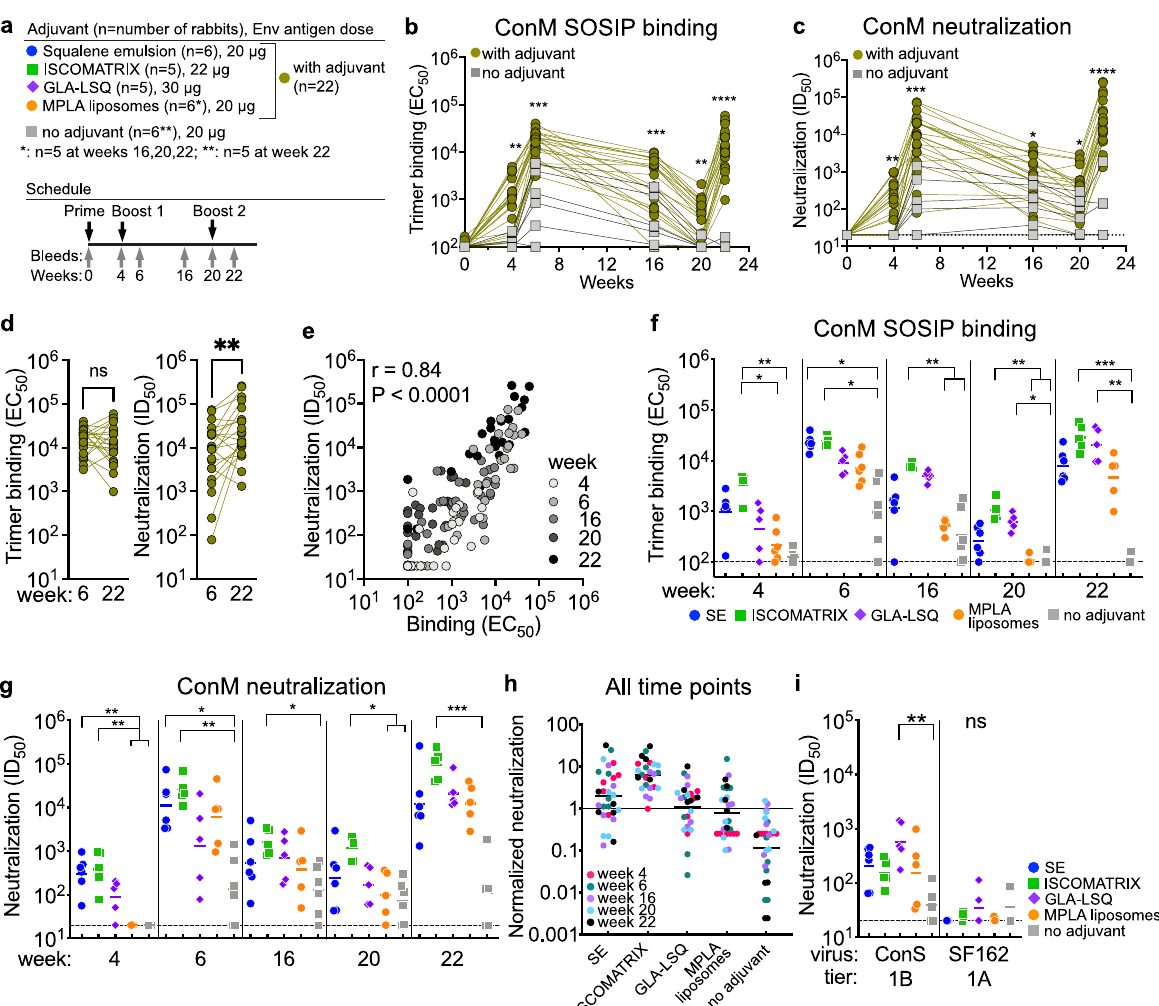
Fig. 1 Effect of adjuvants on trimer immunogenicity in rabbits. a Schematic representation of the rabbit immunization schedule. Rabbits were immunized at weeks 0, 4, and 20 with ConM SOSIP.v7 trimer in the indicated adjuvants. Bleeds were taken at 0, 4, 6, 16, 20, and 22. Every color represents a speci fi c adjuvant. The same color icons are used throughout all fi gures. b Midpoint serum-binding titers (EC 50 ) measured against ConM SOSIP.v7 trimer in ELISA. Differences between nonadjuvanted and the pooled adjuvanted groups were compared at each time point by the Mann – Whitney U test. c Midpoint serum-neutralization titers (ID 50 ) measured against ConM virus. Differences between nonadjuvanted and the pooled adjuvanted groups were compared at each time point by the Mann – Whitney U test. d Comparison of binding and neutralization titers two weeks after the second (week 6) and third immunization (week 22) from the pooled adjuvanted trimer group. A Wilcoxon test was used to determine differences. e Simple linear regression analysis of the midpoint binding titers and ConM neutralization titers over all postprime time points. The Spearman r values and p-values are indicated. f Comparison of the midpoint trimer binding titers between the adjuvanted trimer groups. g Comparison of the ConM neutralization titers between the different adjuvants. h Each individual ID 50 titer was normalized against the corresponding geometric mean ID 50 normalized to 1.0 (horizontal line). Shown are the pooled normalized ConM neutralization titers from all postprime time points. i Week 22 serum-neutralization titers against Tier 1B ConS virus and Tier 1 A SF162. Stars denote statistical differences: * p < 0.05; ** p < 0.01; *** p < 0.001 determined by Kruskal – Wallis test, followed by Dunn ’ s post-test unless otherwise noted. ( h ) contains published data, see also Supplementary Table 2 11,56 . All data were generated at the AMC. Horizontal lines represent geometric mean